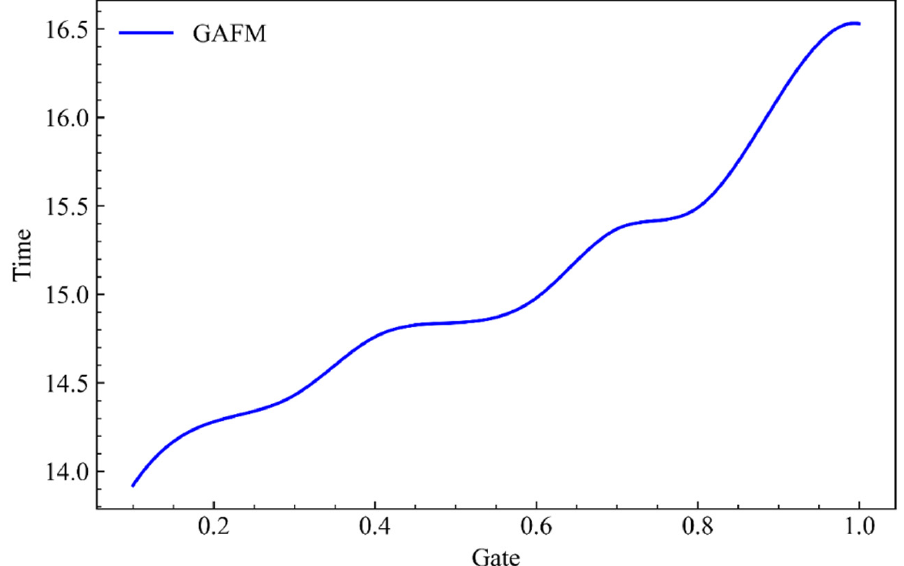
Figure 11. Running time of GAFM under the influence of g. (2) The second is the experimental effect on dataset 2, which is the Movielens dataset with the size of 1 M: As can be seen from Figure 12, in data set 2, when parameter g remains unchanged and parameter drop keeps increasing, we can find that the results presented by the model are almost consistent with the experiments related to accuracy, but with more unstable fluctuations.